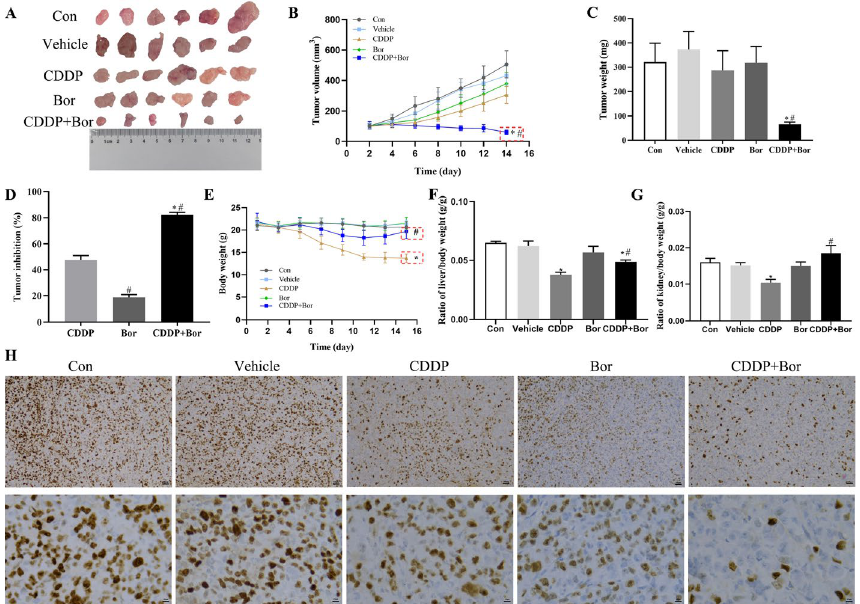
Fig. 6 d-Borneol potentiates CDDP antitumor activities in vivo. A Representative photograph of tumors in different treatment groups; B tumor volume; C tumor weight; D tumor inhibition; E body weight; F organ index of liver; G organ index of kidney; H immunohistochemical staining of Ki67 from tumor tissues. Each value represent mean SD ( n 6, * P < 0.05, compared with Con, Vehicle, Bor group; # P < 0.05, compared with ± = CDDP